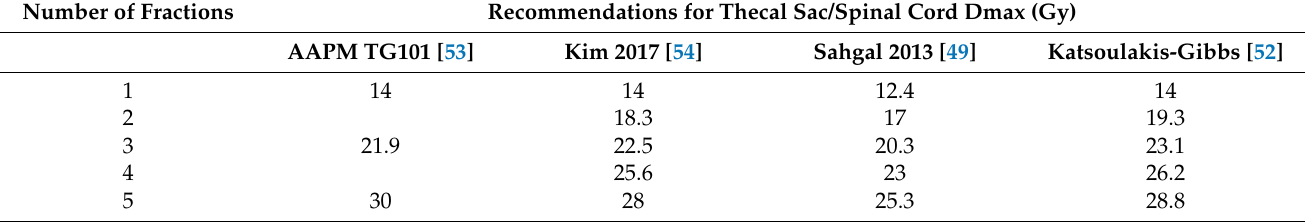
Table 4. Dose model-derived limits from publications, for the first course of SBRT, for RM risk of 1–5%. Number of Fractions Recommendations for Thecal Sac/Spinal Cord Dmax